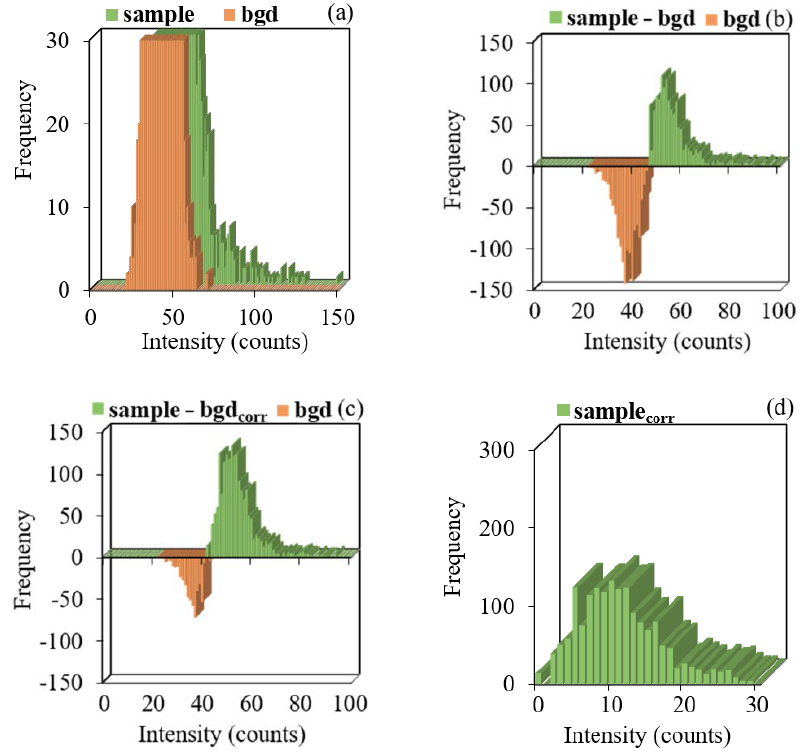
Figure 5. Signal distributions of the background and sample 3: ( a ) before correction of the background signal, after correction, ( b ) for the frequency of the background signal; corrected frequency of the background signal considering the number of NPs in the sample, ( c ) and considering the mean intensity of the background signal ( d ).